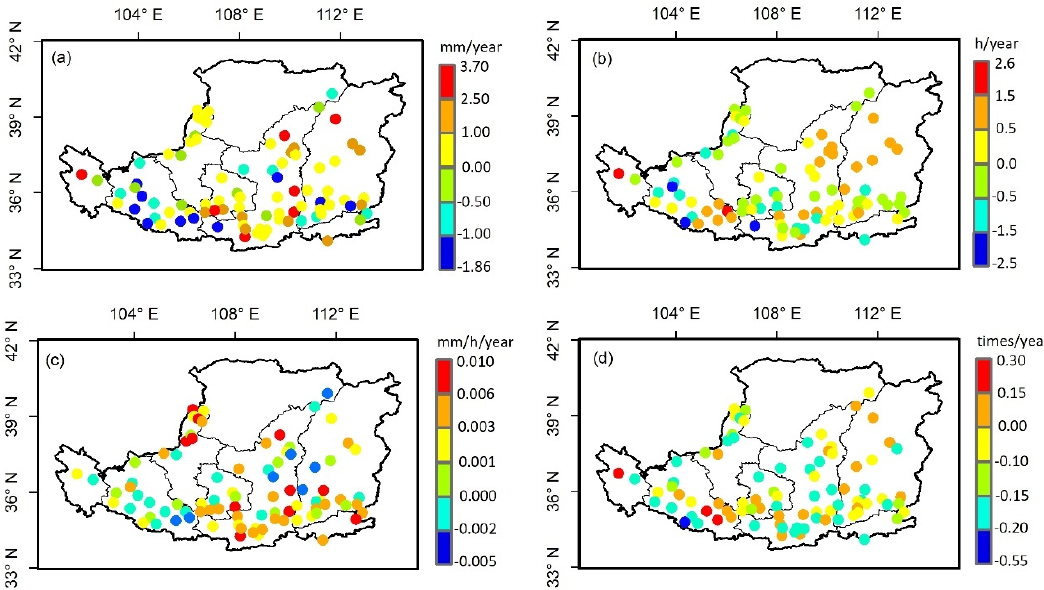
Figure 3. Spatial patterns of ( a ) ATR, ( b ) ARF, ( c ) ARI and ( d ) ATE trend magnitude for the RS from 1983 to 2012 in the plateau. Note: the significance levels α = 0.05 to test trend statistical